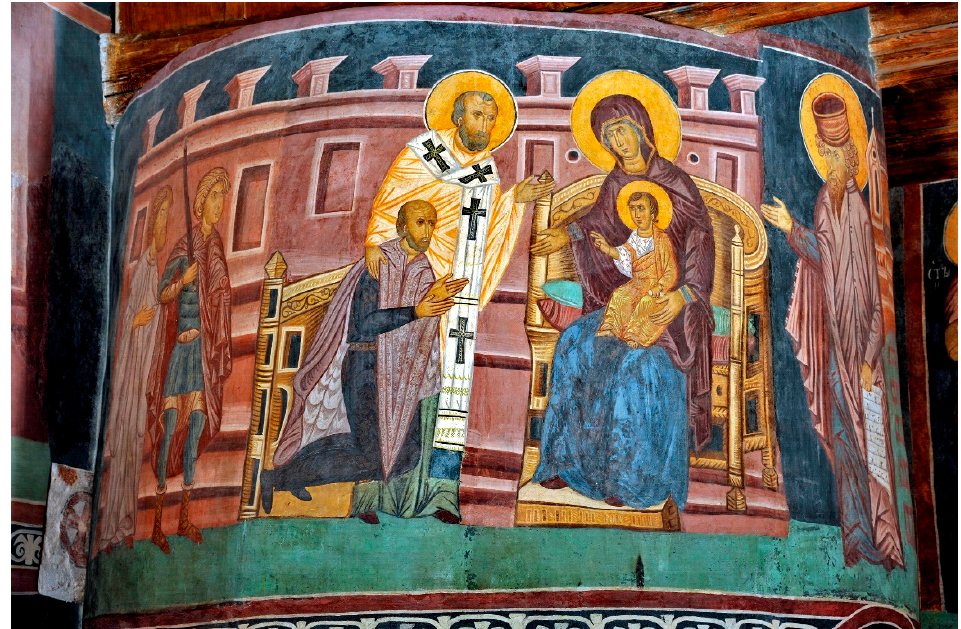
Figure 2 . Ladislaus Jagie łł o in adoration of the Virgin and Child, frescoes, 1418, Lublin, royal